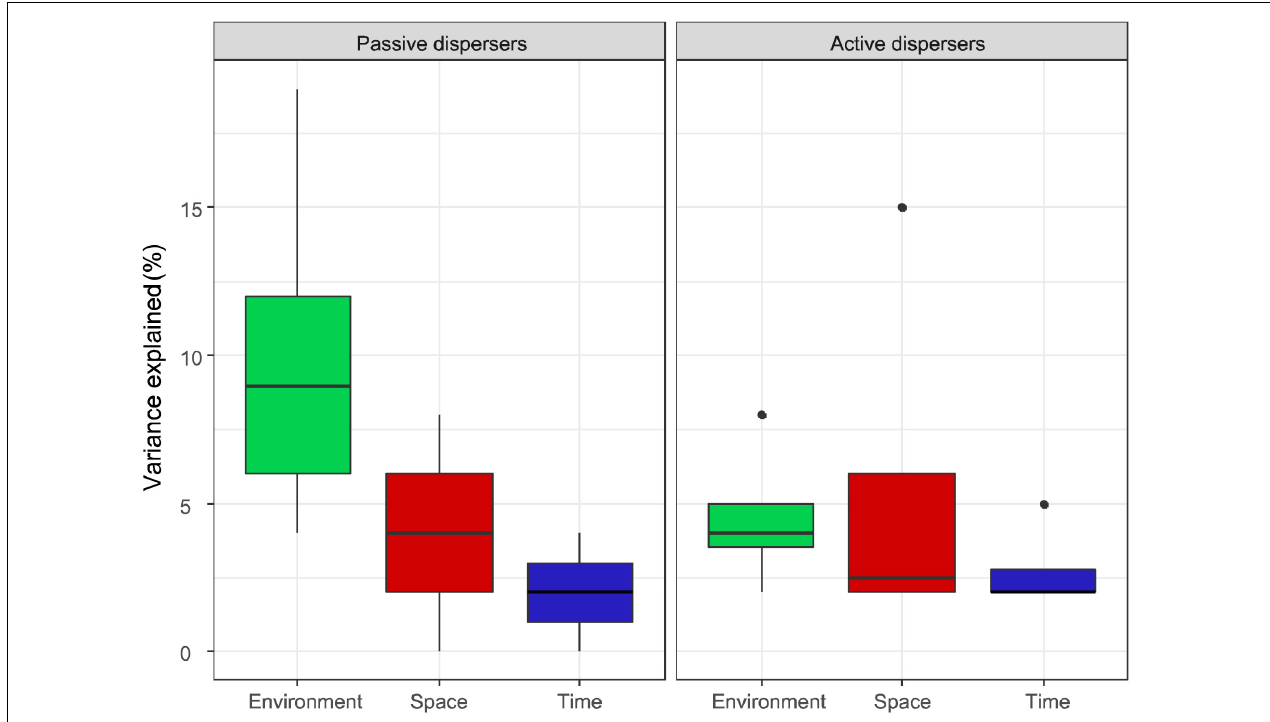
FIGURE 3 | Percentage of metacommunity variance explained by pure environmental, spatial and temporal components, according to the type of dispersal of the studied groups of organisms.